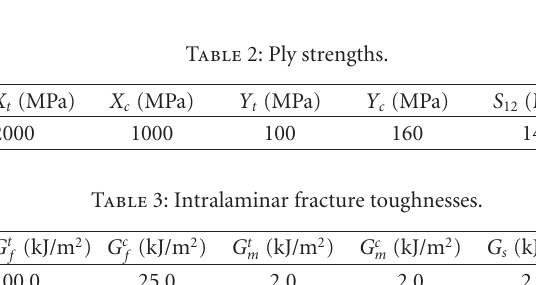
Figure 12: Damage evolution law due to combined tension and compression loading in the matrix direction.